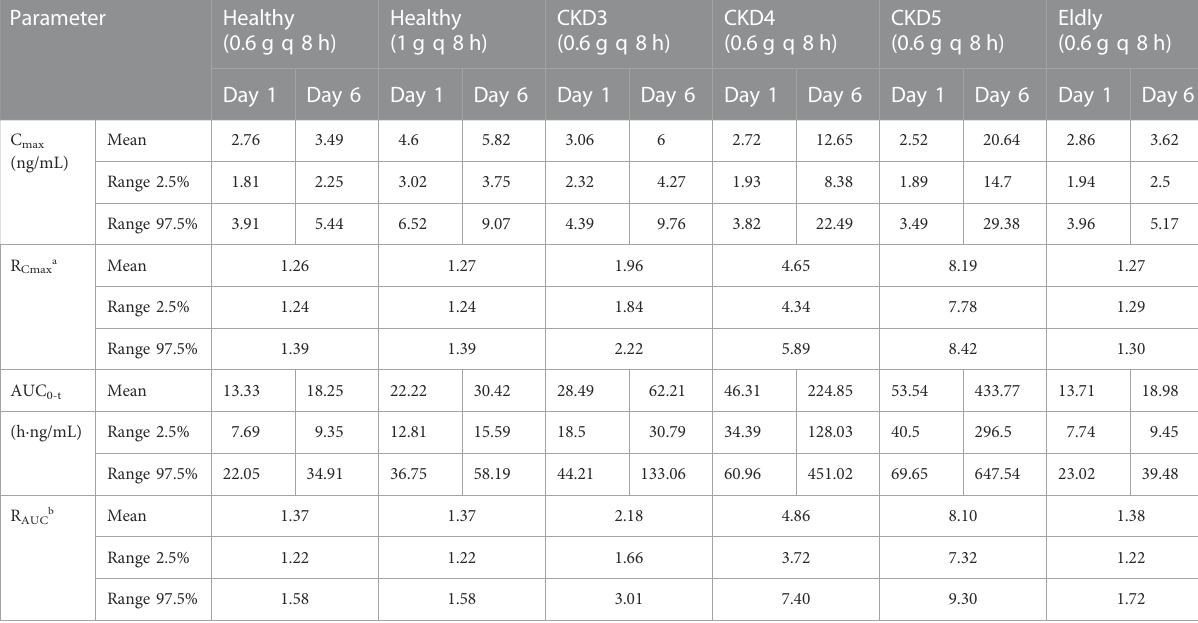
TABLE 6 Predicted pharmacokinetic parameters of schaftoside following oral administration of TFDS at 0.6 g/1 g q 8 h.